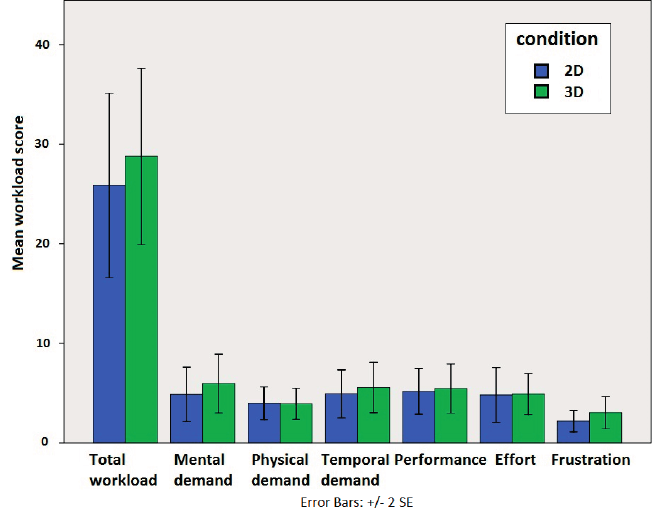
Figure 12. Total workload score and workload scores on the individual subscales of the NASA TLX (Task Load Index)